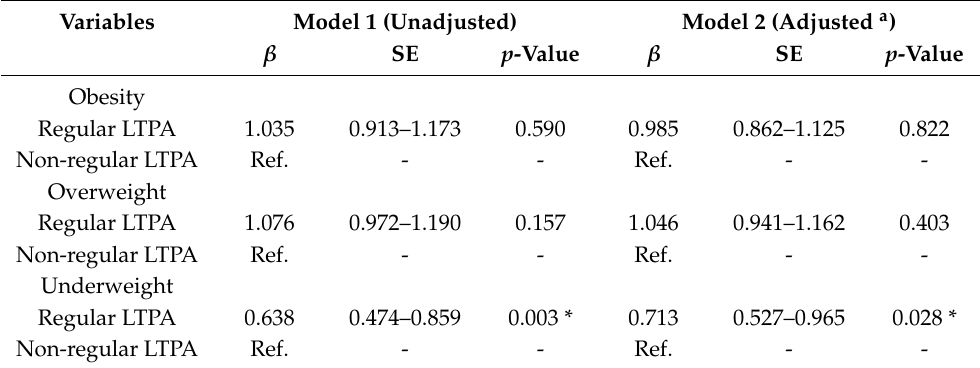
Table 5. Multivariate logistic regression for regular LTPA and risk of obesity, being overweight, and being